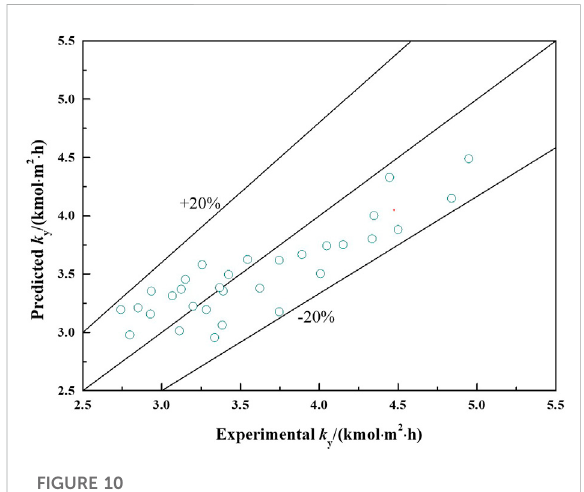
FIGURE 10 Predicted k y in comparison with experimental k y for all the tested